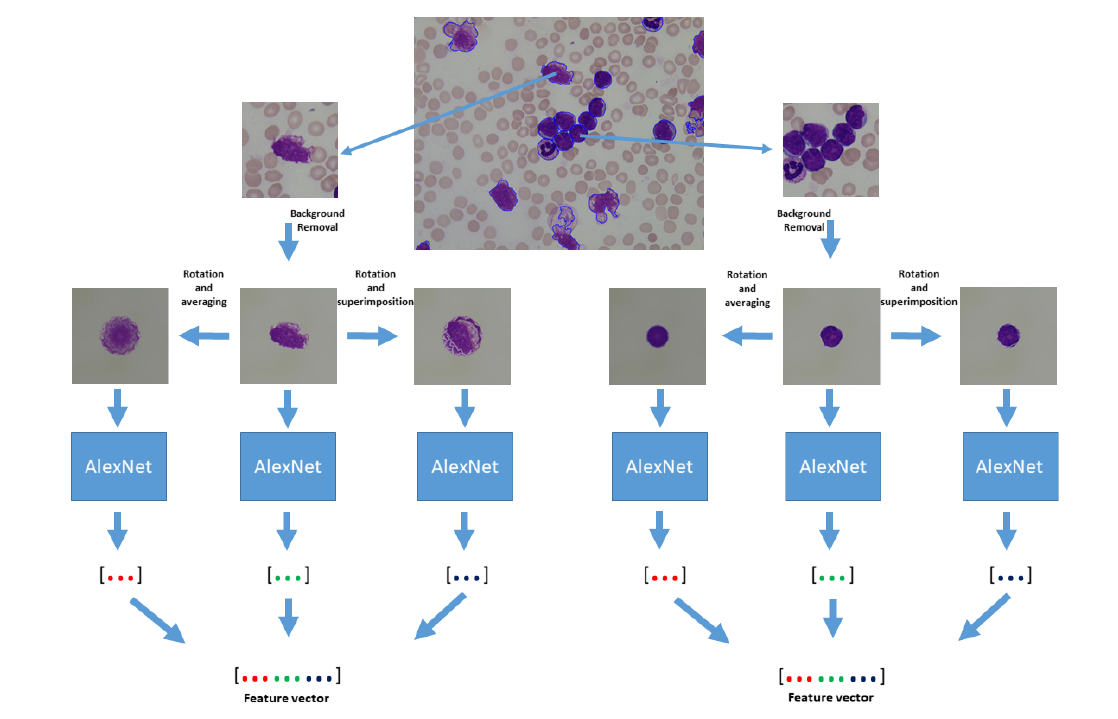
Figure 8. Feature extraction step applied to several segmented elements of the input